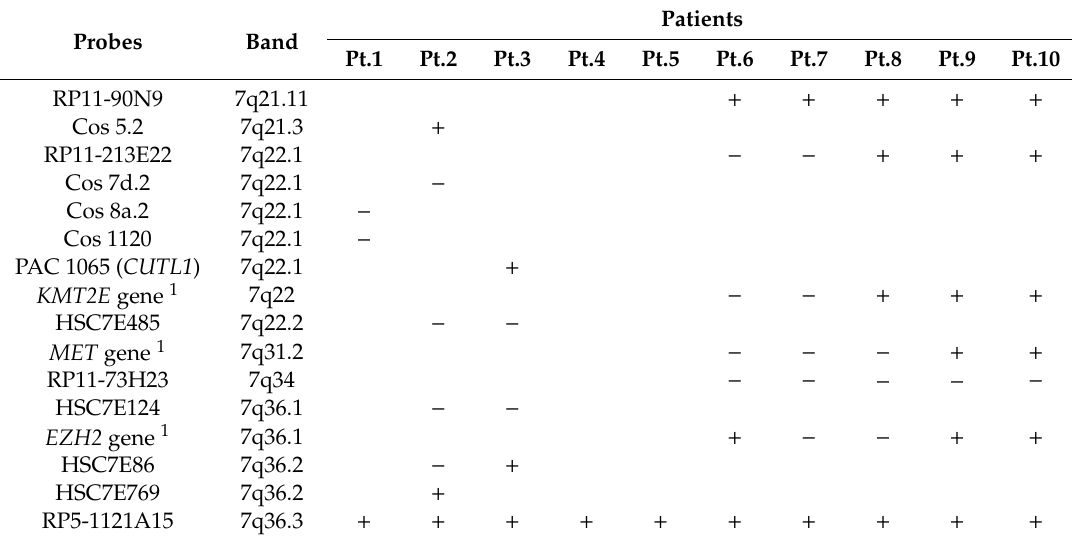
Table 2. Fluorescence in situ hybridization (FISH) mapping of chromosome 7 deletion